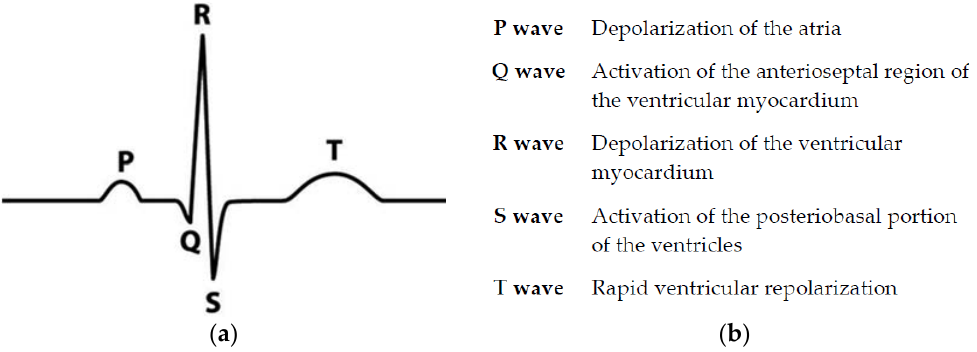
Figure 1. Ideal electrocardiogram (ECG) signal with key features indicated; ( a ) P wave, QRS complex, and T wave which play important roles in diagnosis abnormality of heart signal; ( b ) Features of an ECG signal; how and which part of heart is used to generates each feature [16].